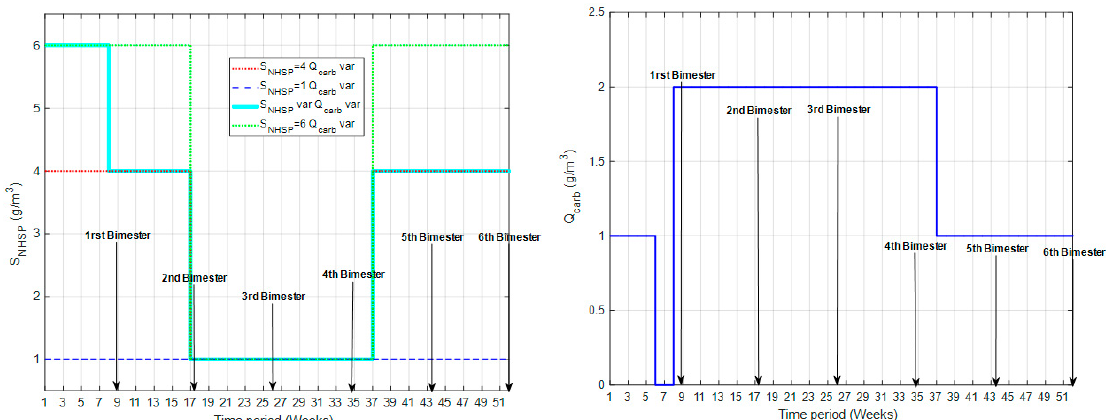
Figure 10. Ammonium set-point S NHSP (g / m 3 ) and Q carb (m 3 / d) variations considered as alternative control actions.